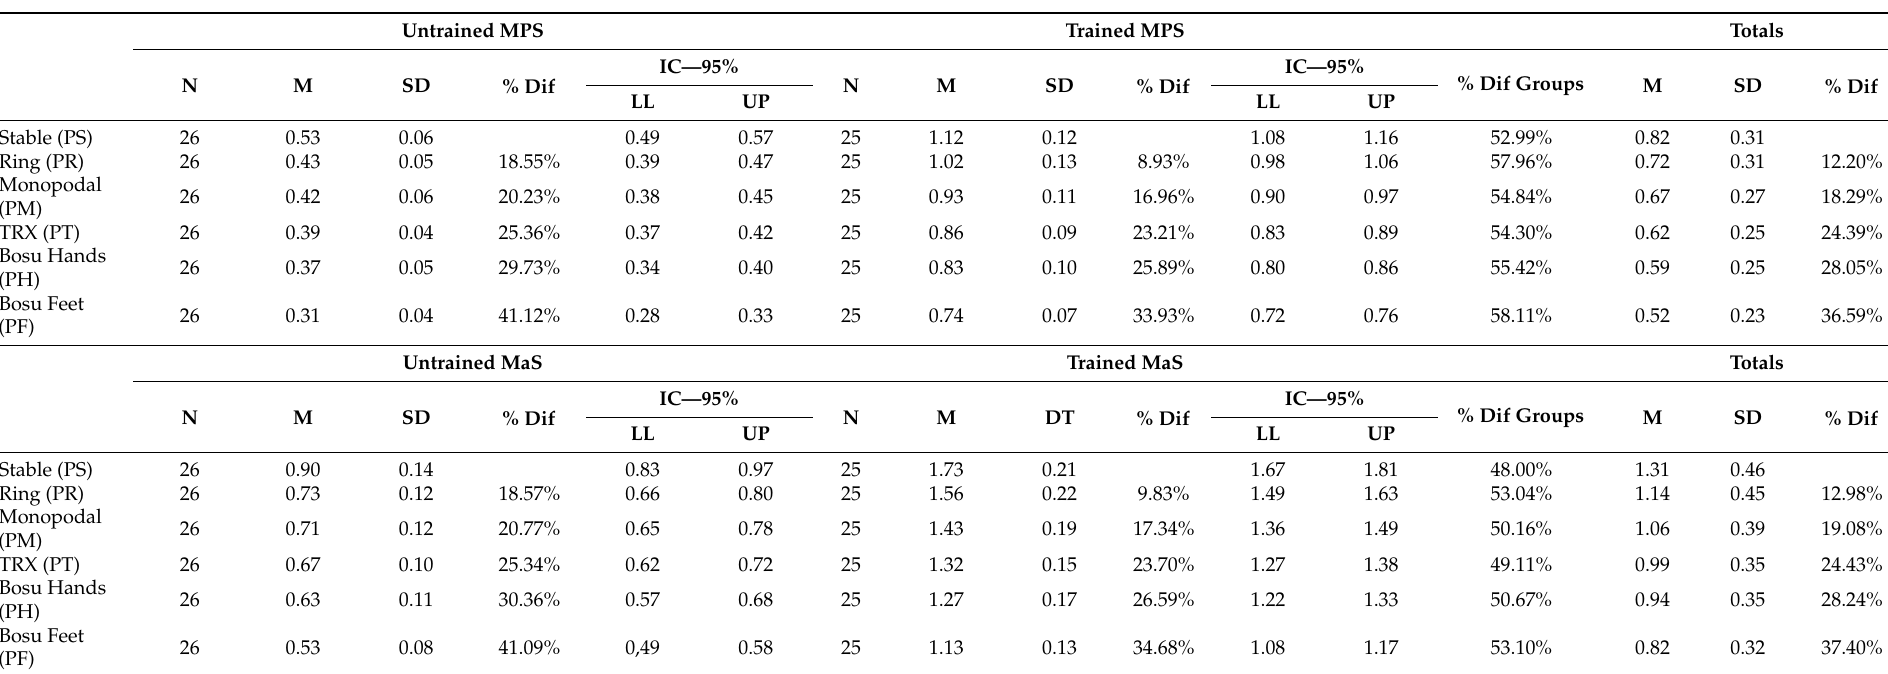
Table 3. Descriptive statistics for mean propulsive speed (MPS) and maximum speed (MaS) measured in meters per seconds (m/s) as a function of